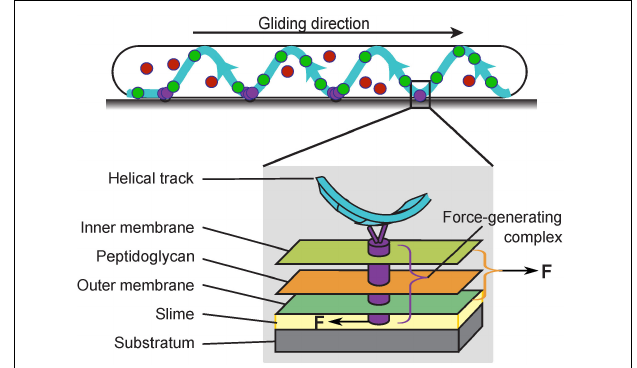
FIGURE 1 | The gliding machinery of Myxococcus xanthus . The AglR/Q/S motors can be categorized into three subpopulations: those in the stationary force-generating complexes (purple), those undergoing directed motion along helical trajectories (green), and those that are diffusive (red). The fully assembled force-generating complexes span the entire cell envelop (gray box). To propel the cell forward, the force-generating complexes must exert opposite forces on the cell and